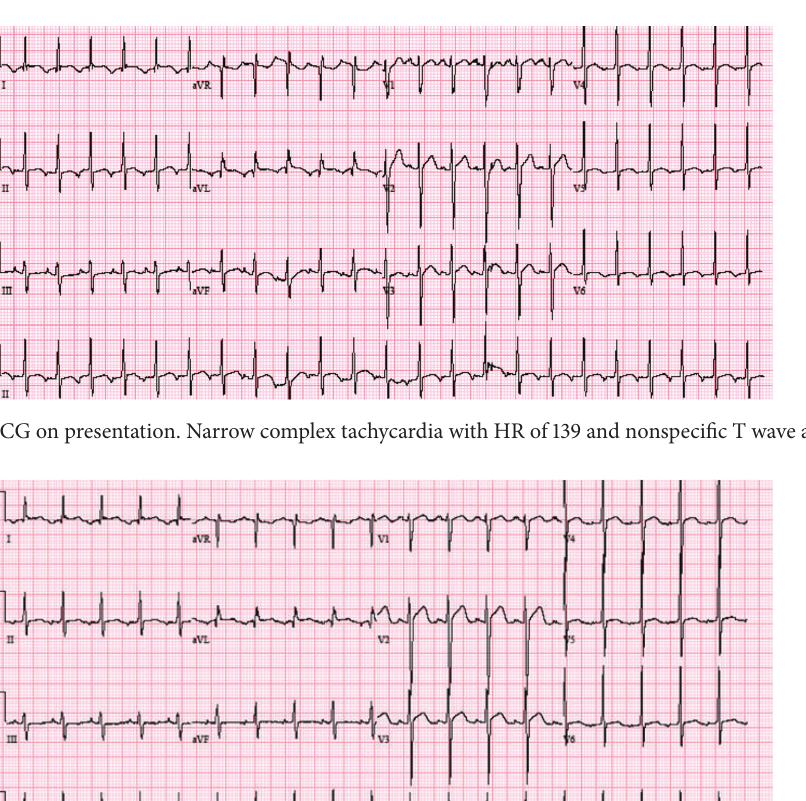
the criteria for noncompaction cardiomyopathy (Figure